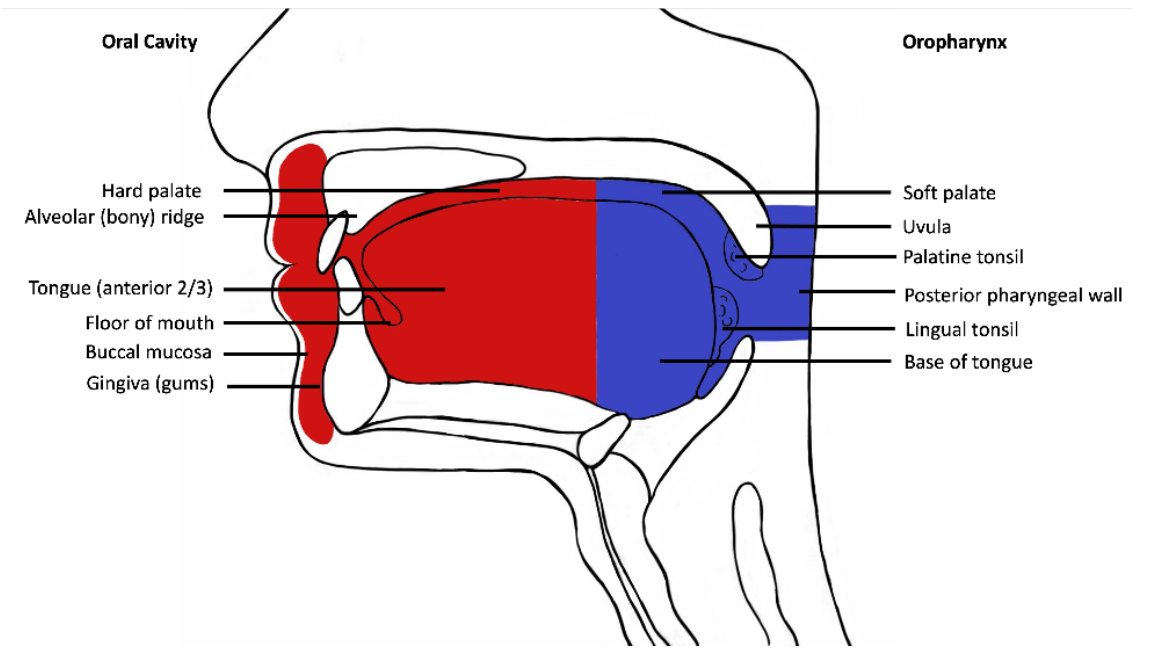
Figure 1. Schematic diagram demonstrating oral cavity anatomy. Oral cavity is depicted in red and oropharynx in blue.